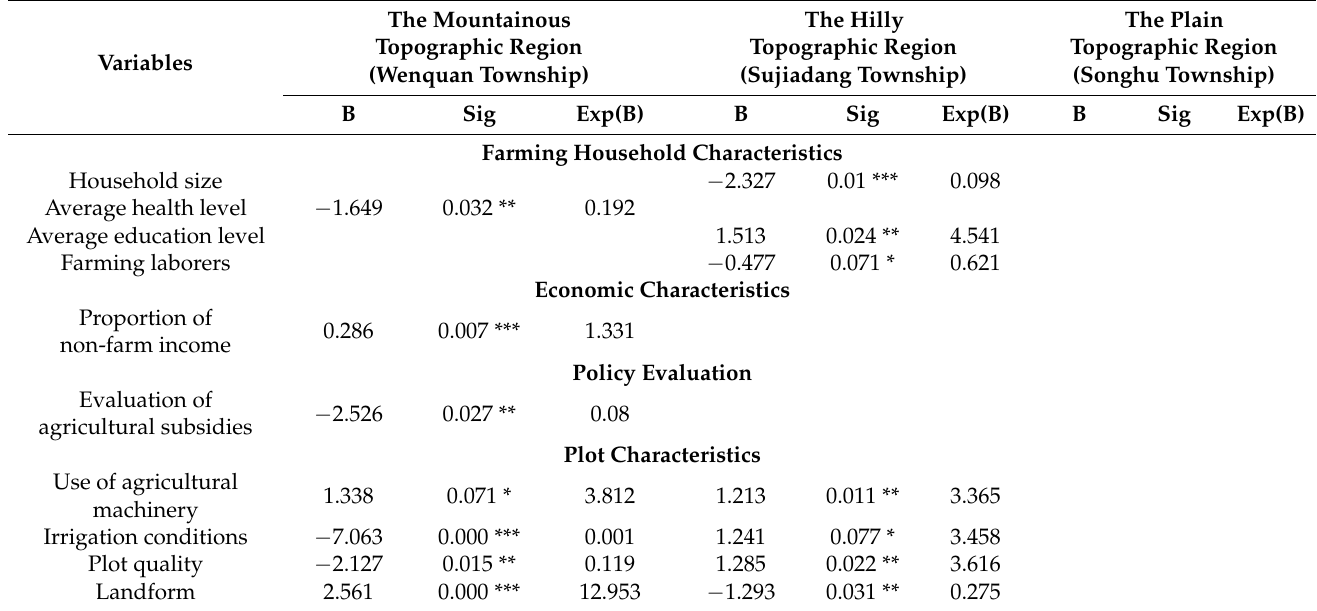
Table 11. Subsample results of non-farm households in three topographic regions.